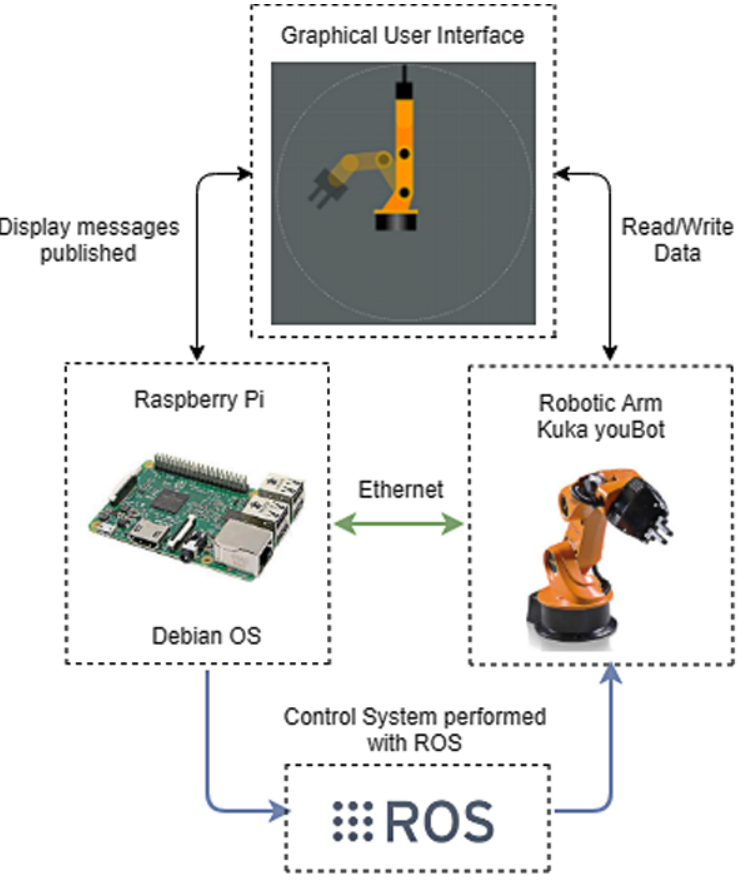
Figure 6. Study Case